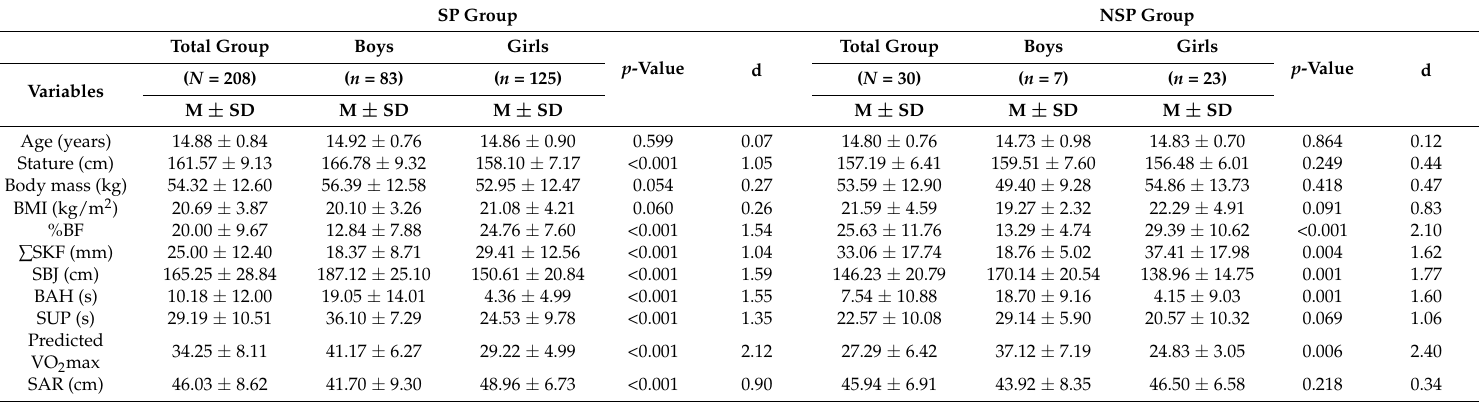
Table 1. Mean and standard deviation of anthropometric, body composition and physical fitness characteristics of adolescents by sport participation and gender.